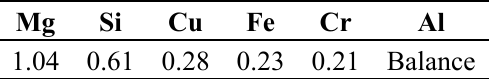
Table 1. Chemical compositions of aluminum powder A6061 (mass %).